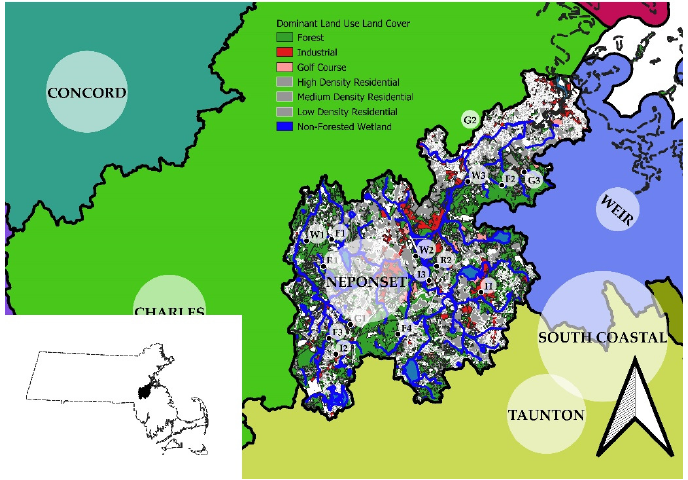
Figure 1. Map of the 14 Neponset River Watershed dominant Land Use Land Cover pore points determined by Huang and Chen 31 resulting in this study’s 8 sampling stations (R = Residential; F = Forested; I = Industrial, G = Golf, W = Wetland) sampled in water year 2010 and 2012. Map created by Alan Christian.